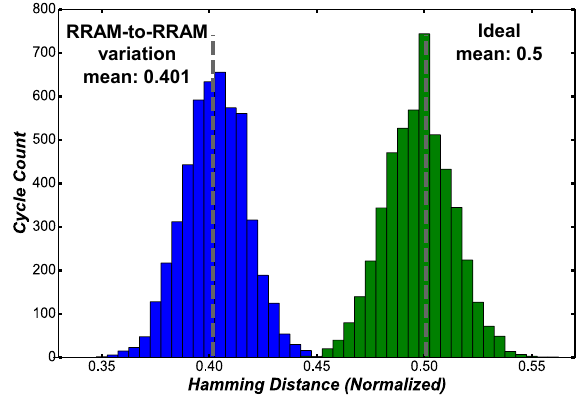
Figure 20: The simulated inter-configuration hamming distance with and without the RRAM-to-RRAM variation. The HD config is shifted even lower than the one in Figure 18, implies that the RRAM-to-RRAM variation has more impact on the SET